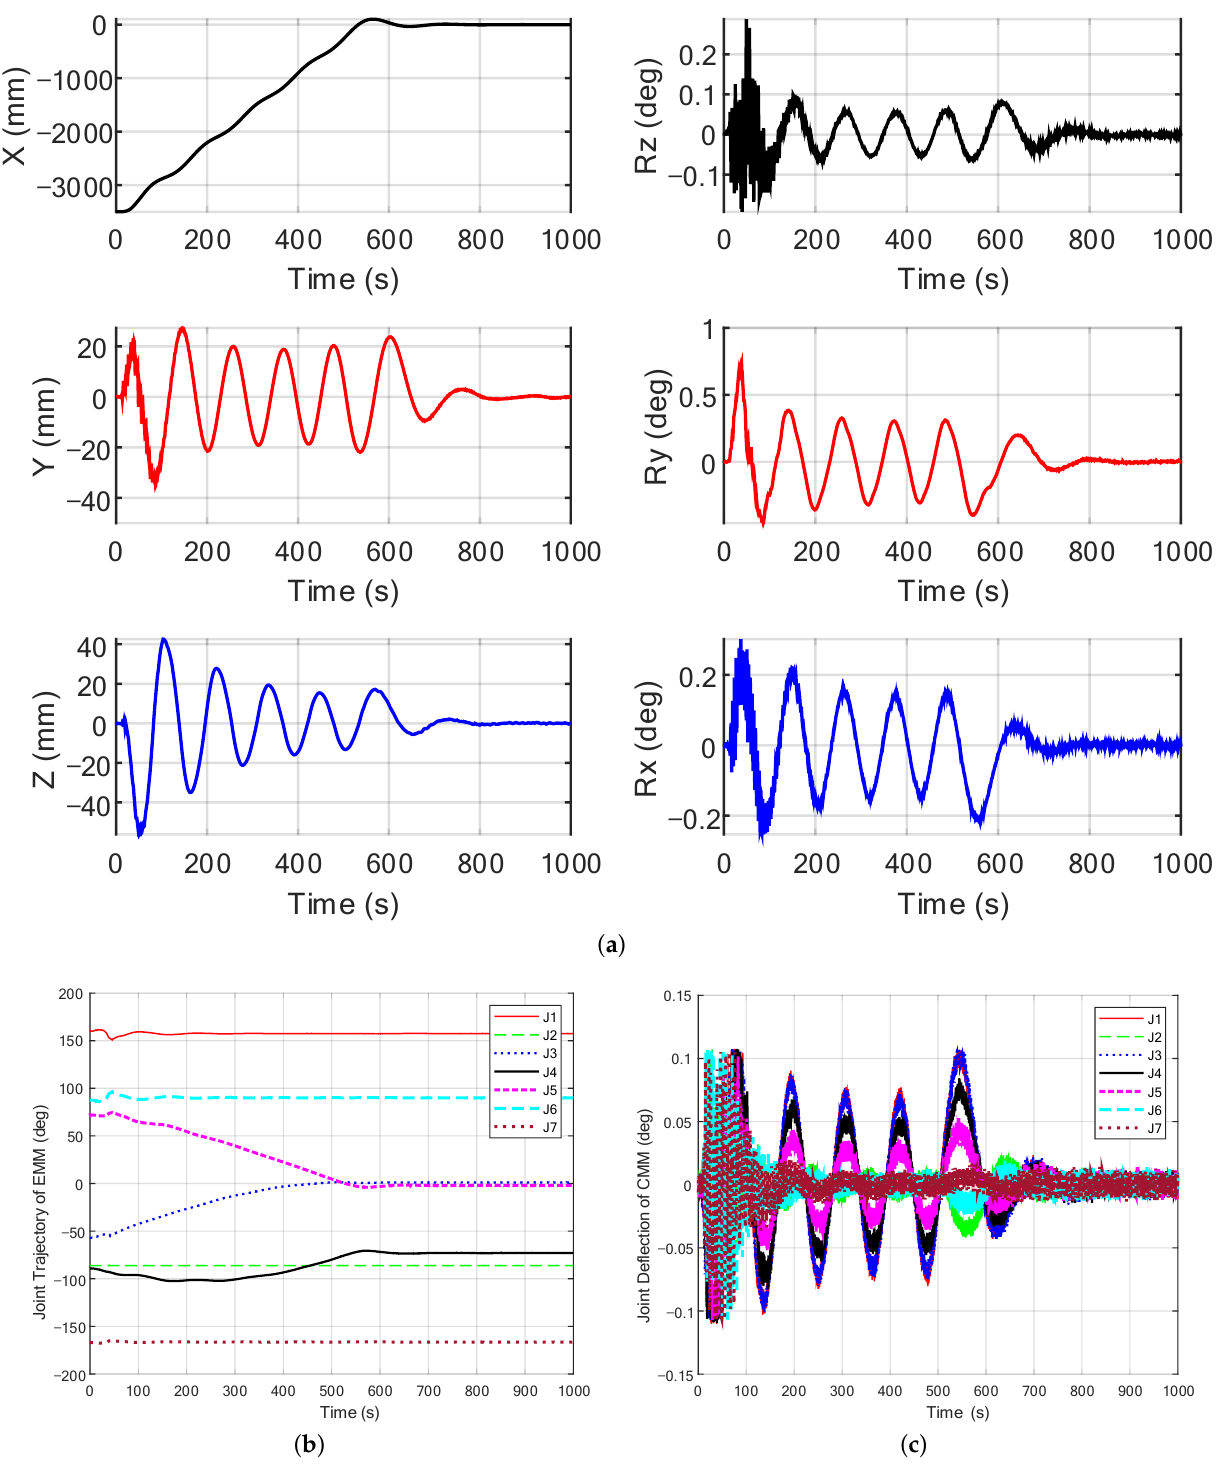
Figure 8. Base deflection and base energy. ( a ) The relative position and orientation of the visual servo. ( b ) The joint angle of EMM. ( c ) The joint deflection of